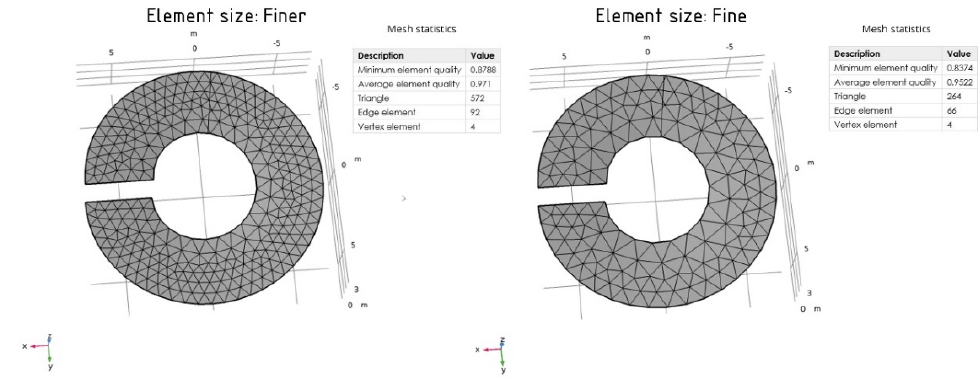
Figure 9. The use of two element sizes for the mesh. The maximum displacement value is 53.46 mm. The values of the first principal stress are − 1.5 × 10 − 15 MPa (minimum) and 7.11 MPa (maximum). For the second principal stress, the minimum value is − 12.96 MPa and the maximum value is 0.42 MPa. The values of the third principal stress are 3.5 × 10 − 16 MPa (maximum) and − 33.60 MPa (minimum). The total elastic strain energy is 18,339.9 J. The graphical diagram showing the maximum and minimum values is presented in Figure 10.